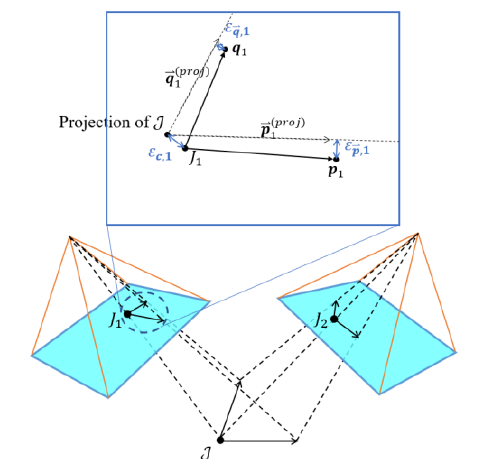
Figure 5. The forward intersection of